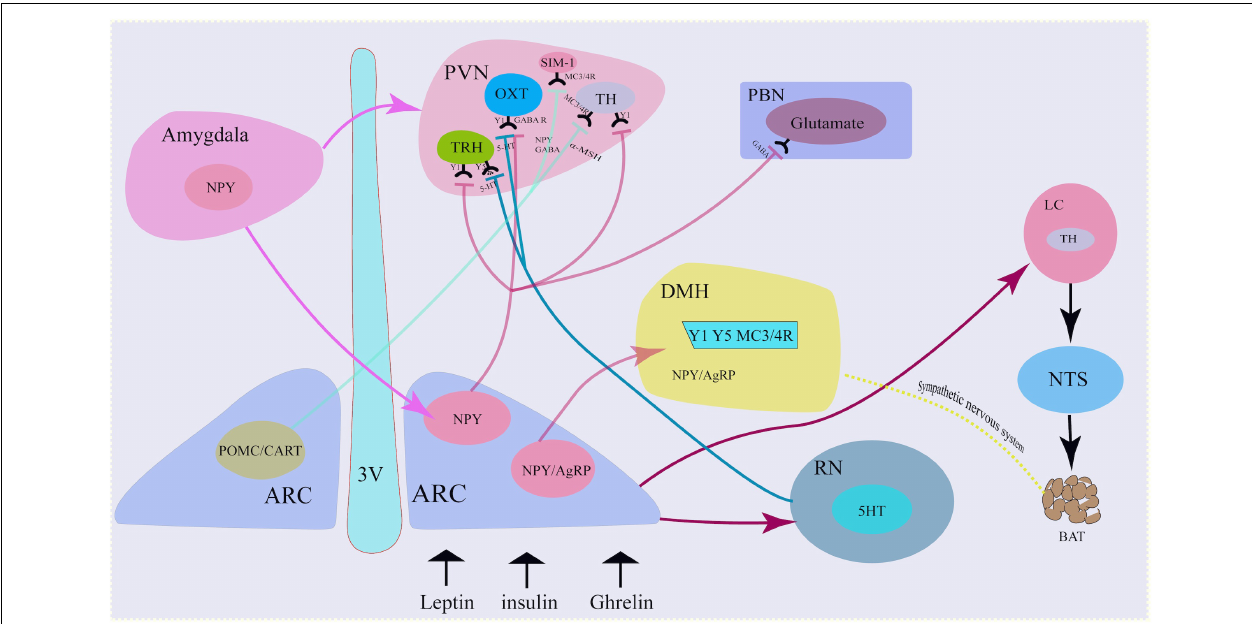
FIGURE 1 | Neural mechanism of NPY neurons. NPY co-locate with neurotransmitters in the sympathetic nervous system. NPY in the Arc projected to the PVN via the activation of Y1 receptors on the TH neurons, TRH neurons and OXT neurons. Similarly, Arc NPY projected to DMH via Y1, Y5, and MC4R receptors. Besides hypothalamus, amygdala also secreted NPY and projected to Arc and PVN. 3 V, third ventricle; ARC, arcuate nucleus; TH, tyrosine hydroxylase; PVN, paraventricular nucleus; NTS, nucleus tractus solitarius; DMH, dorsomedial hypothalamus; LC, locus coeruleus; AgRP, agouti- related peptide; POMC, proopiomelanocortin; CART, cocaine- and amphetamine-regulated transcript; GABA, g-aminobutyric acid; a-MSH, a-melanocyte-stimulating hormone; OXT,